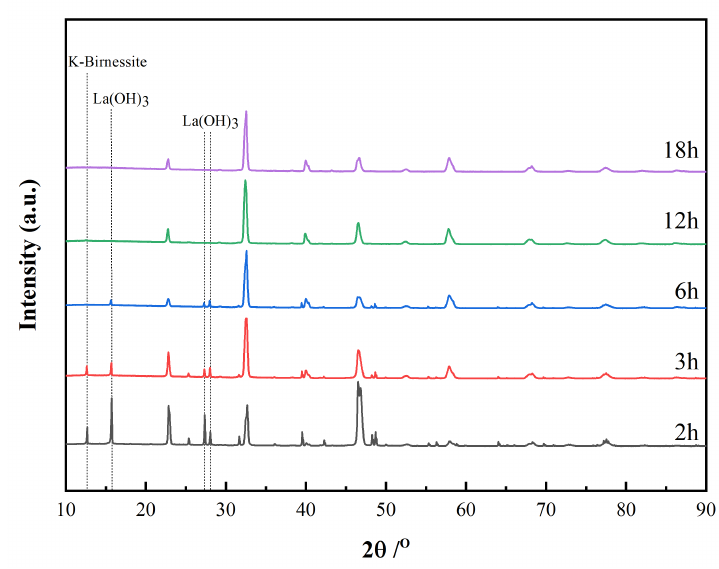
Figure 1. XRD patterns of LaMnO 3 powders for periods of 2, 3, 6, 12 and 18 h. Reflections due to K-rich birnessite and La(OH) 3 are indicated by dotted lines.